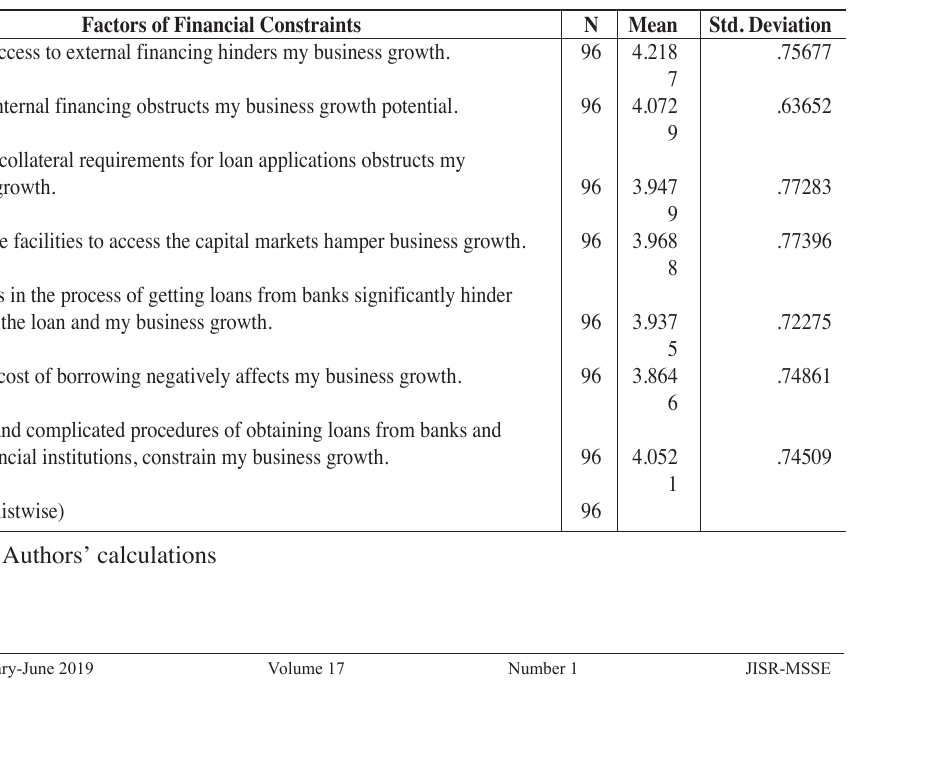
Table 1. Factors of Financial Constraints- Descriptive Statistics Factors of Financial